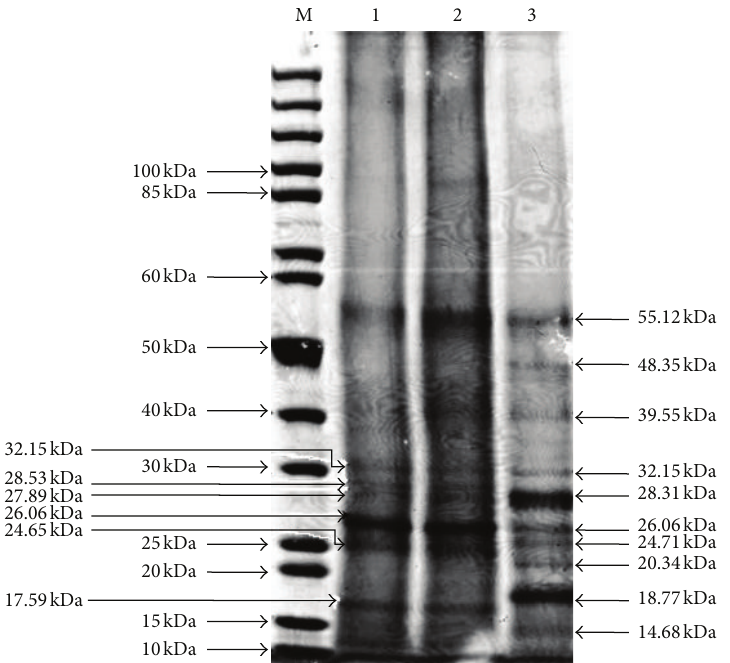
Figure 6: Total protein profile of fruits (1:100% mantled, 2: 50% mantled, 3: phenotypically normal, and M: PageRuler Unstained Protein Ladder).